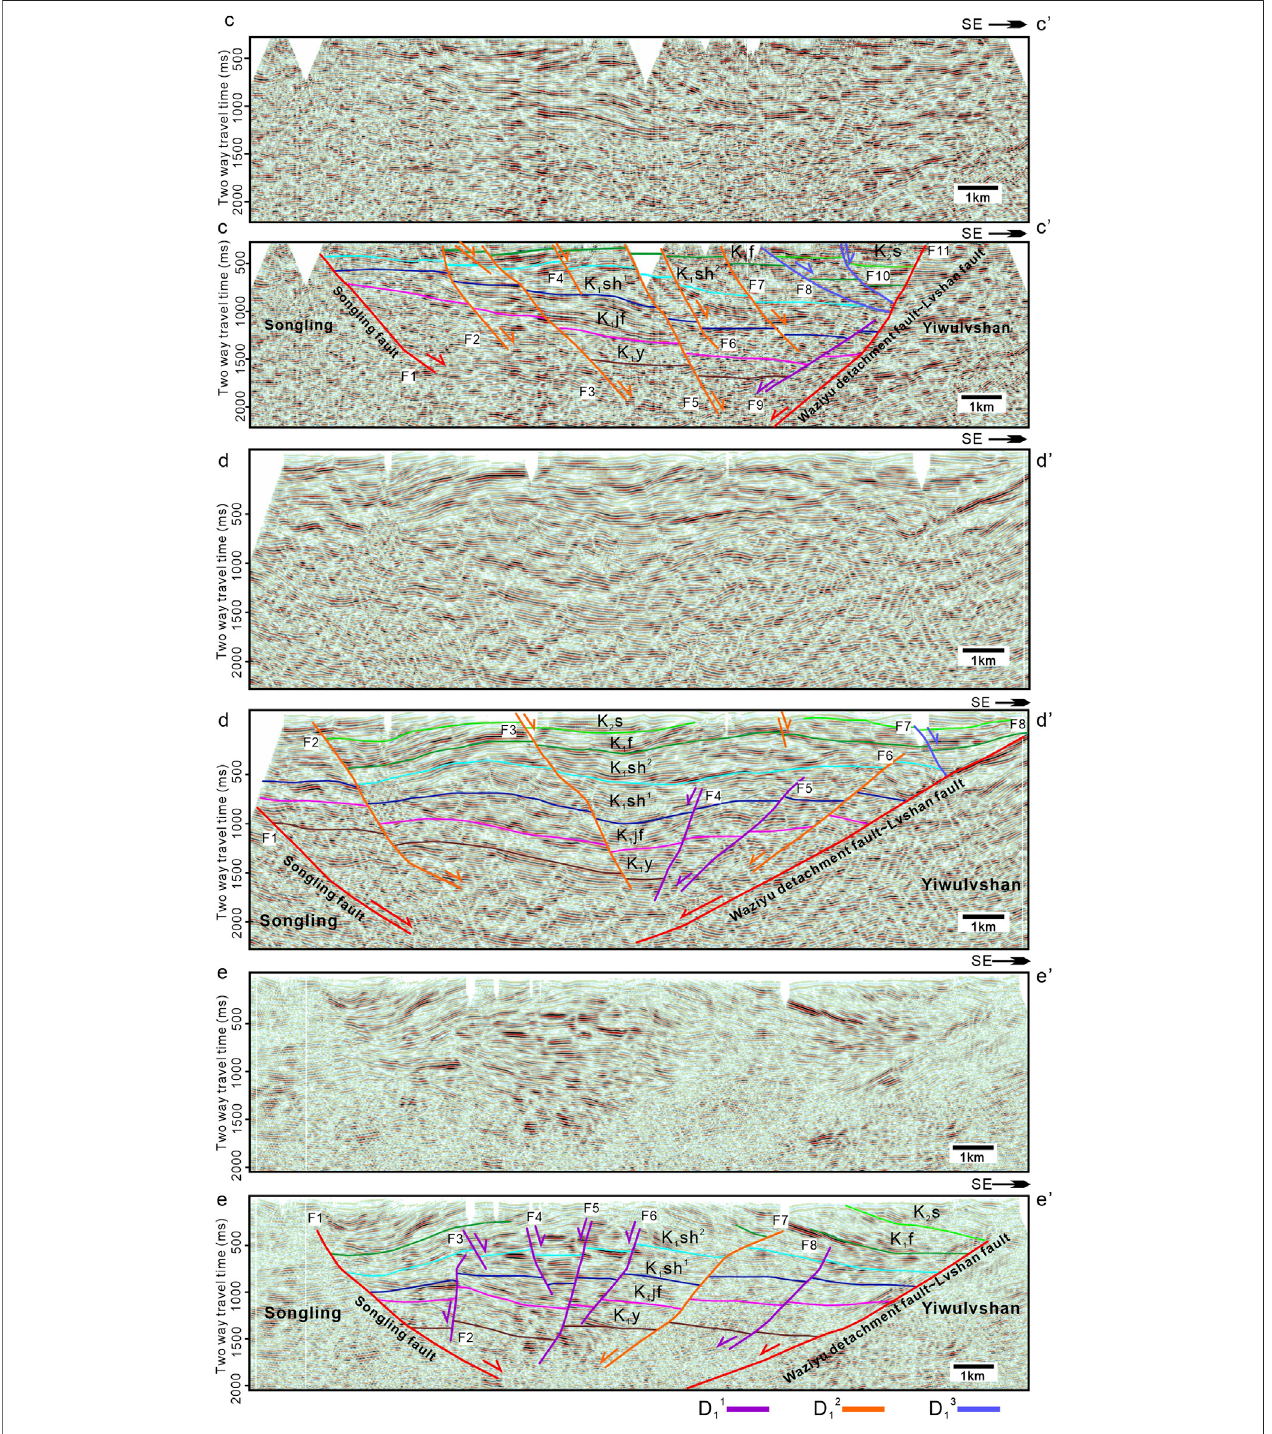
FIGURE 7 | Interpreted seismic pro fi les [ (c,c 9 ) , (d,d 9 ) , and (e,e 9 ) ] across the Fuxin Basin.